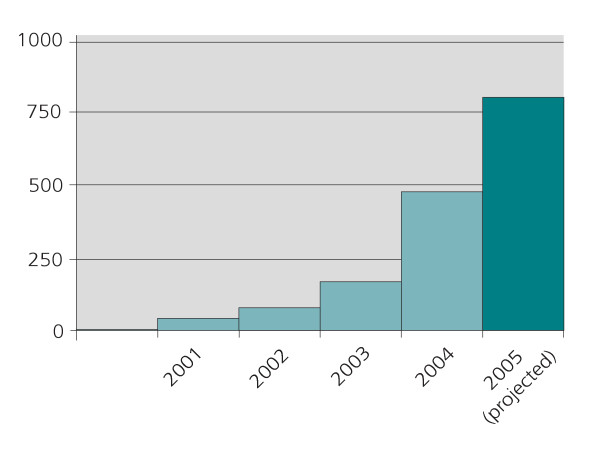
Number of submissions to BMC Bioinformatics. The figure for 2005 represents a conservative projection based on the rate of growth of submissions during the first half of the year.